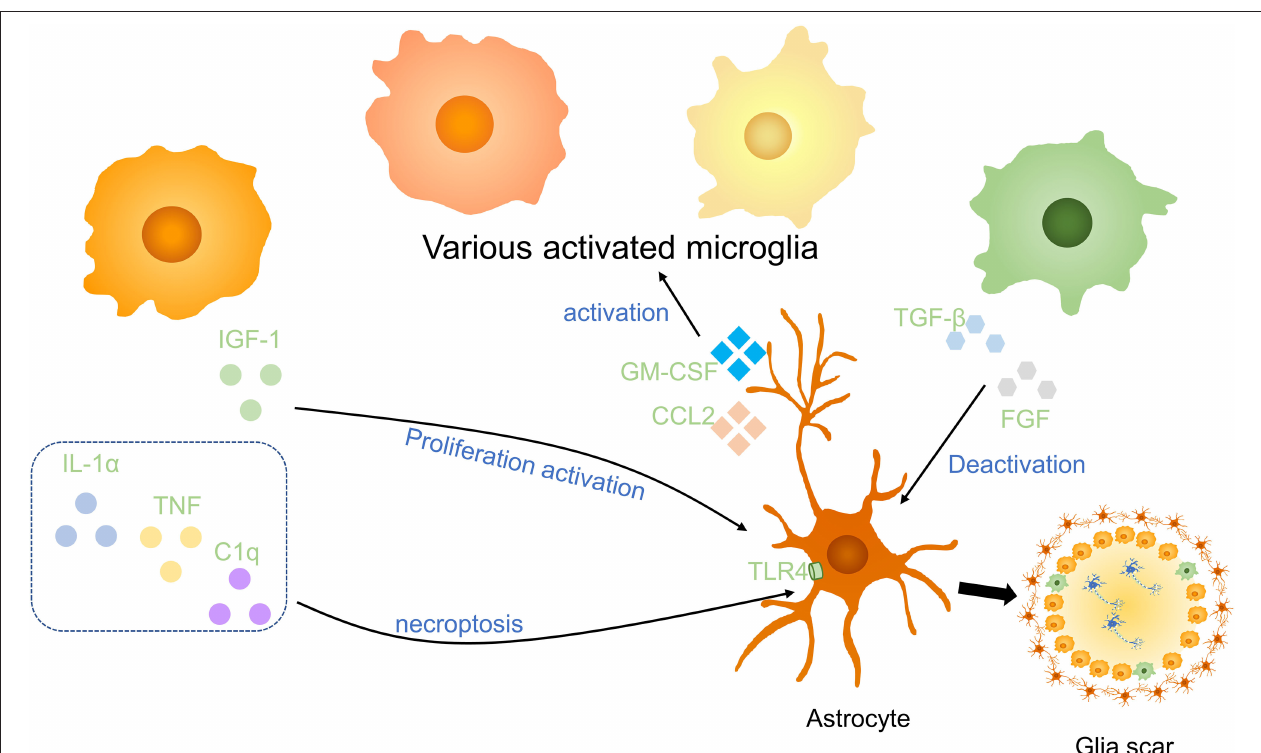
FIGURE 4 | Effects of microglia on astrocytes in SCI. Anti-inflammatory cytokines including insulin-like growth factor-1 (IGF-1) and the combined effect of IL-1 α , TNF, and C1q promote the activation and proliferation of astrocytes. Anti-inflammatory factors, such as TGF- β and FGF, to deactivate astrocytes. Astrocytes activate microglia via GM-CSF and CCL2. Activated microglia and astrocytes are essential parts of glial scars in the injured spinal